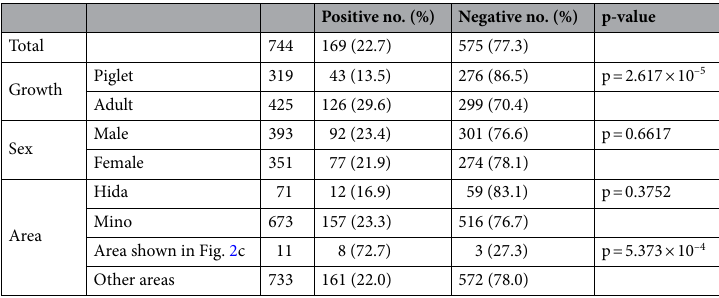
Table 1. Fisher’s exact test for anti- T. gondii antibody seropositivity in wild boars.